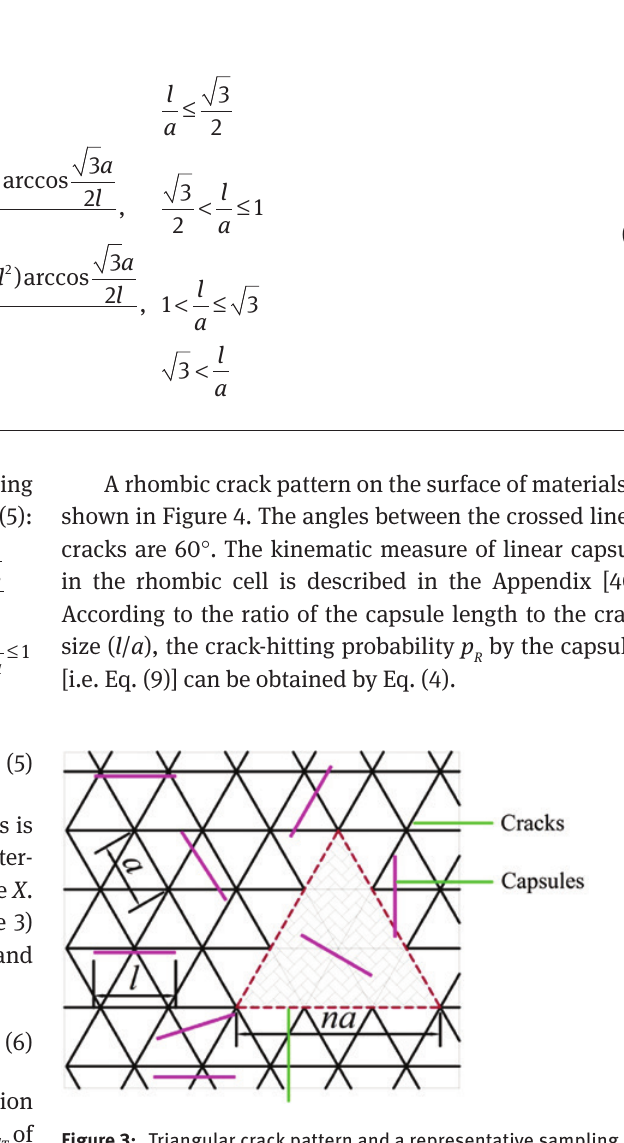
Figure 3: Triangular crack pattern and a representative sampling region E